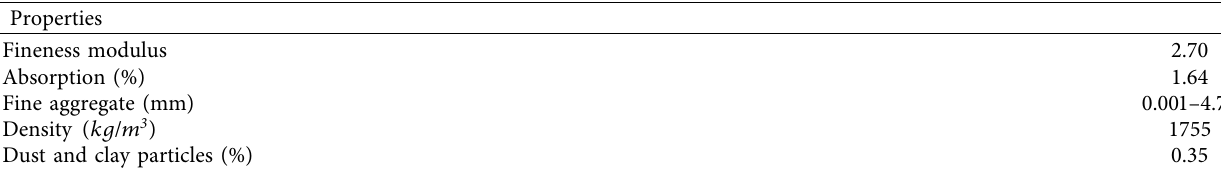
Table 8: Properties of sand [34].